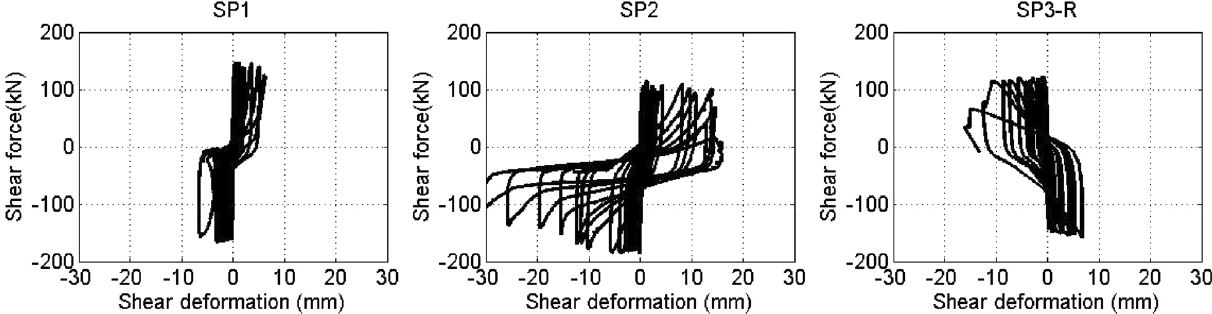
Fig. 19 Beam shear force-shear deformations relationships for SP1, SP2 and SP3-R specimens.